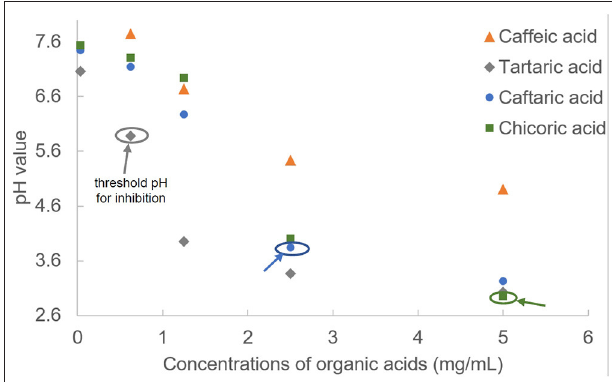
FIGURE 2 | The pH values of organic acids at a series of concentrations. The threshold pH values of organic acids for α -glucosidase inhibition were labeled.